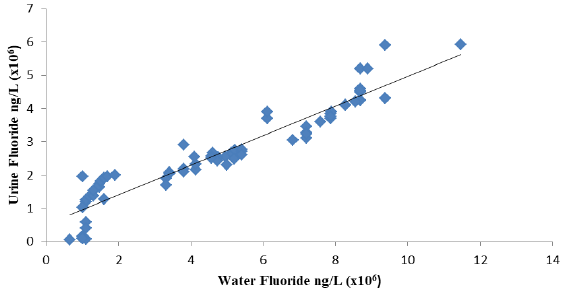
Figure 1: Relationship between Water and Urine Fluoride of RM Participants. Pearson correlation coefficient r = 0.94.